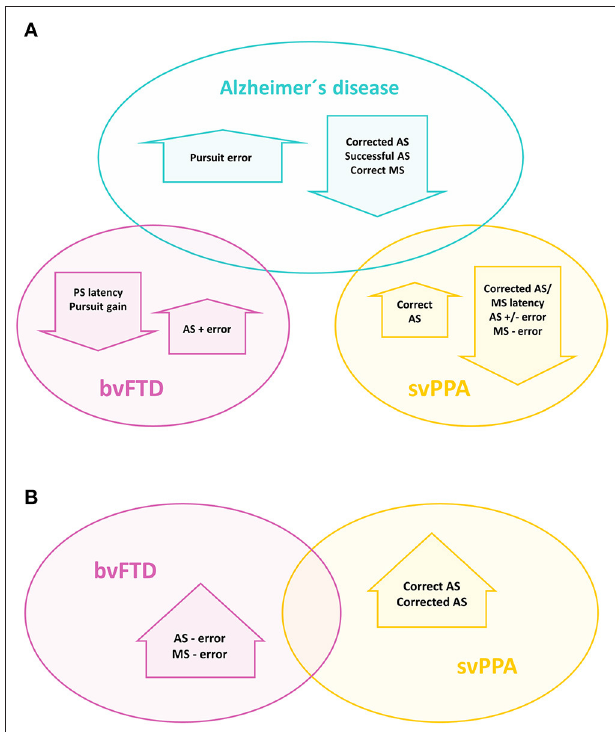
FIGURE 6 | Useful oculomotor parameters for the differential diagnosis between Alzheimer’s disease and the other two dementia groups (A) , and between bvFTD and svPPA (B) . AS, antisaccade; MS, memory saccade; PS,